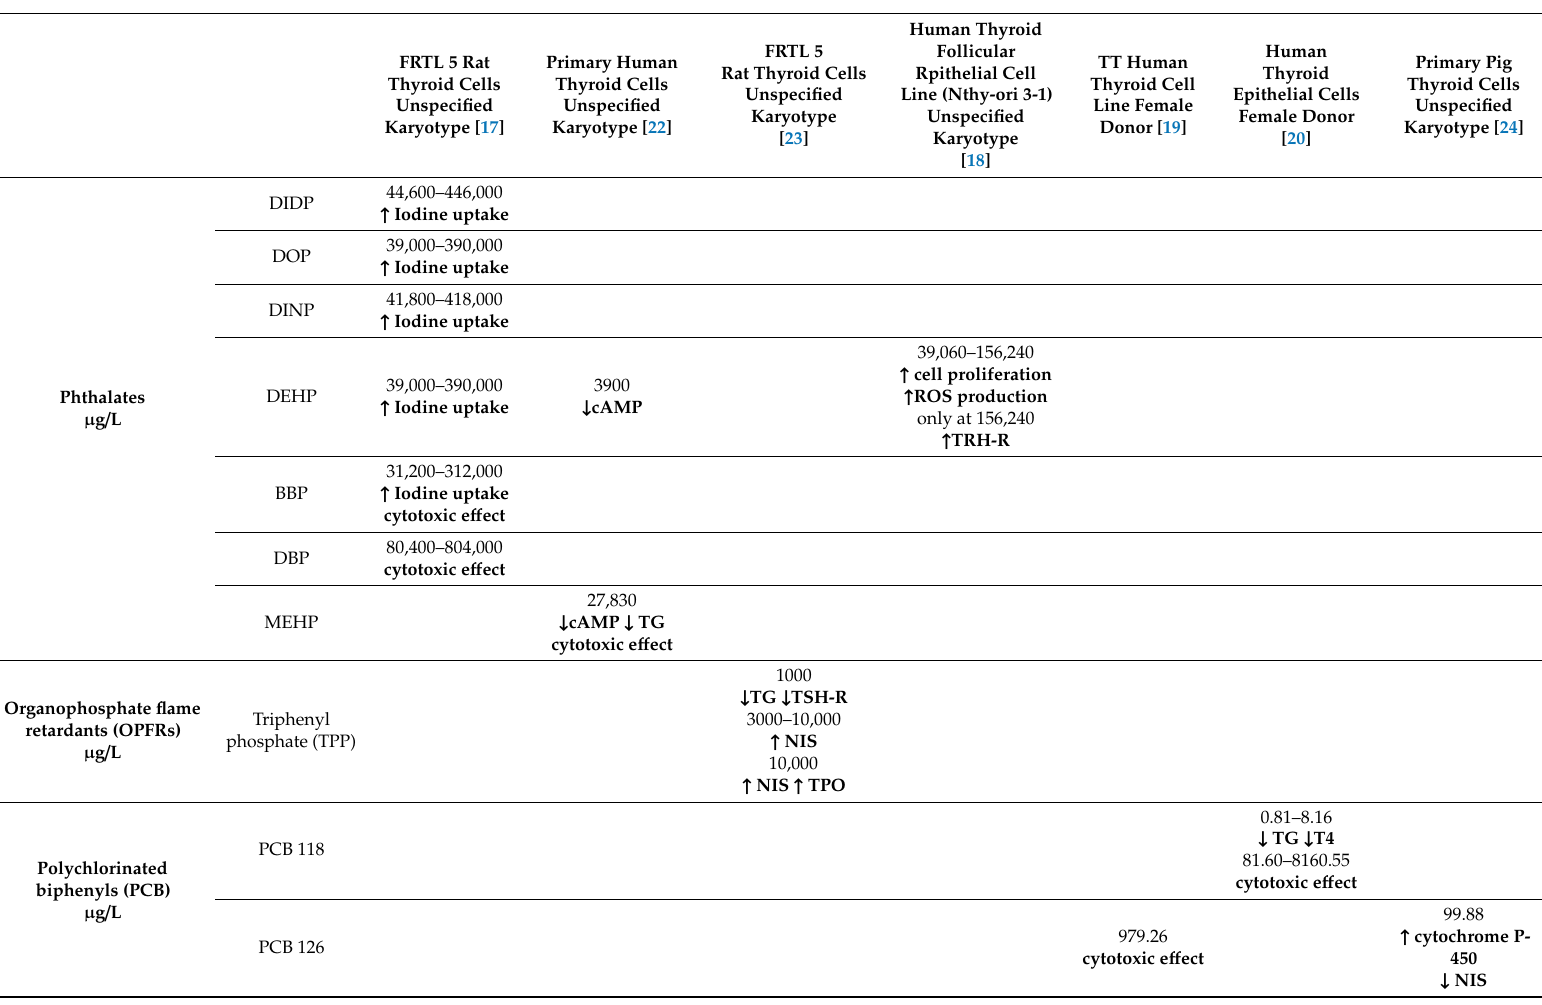
Table 2. Doses of EDs normalized to the same unit of measurement, and their e ff ects on thyroid cell monolayers from di ff erent mammalian species including